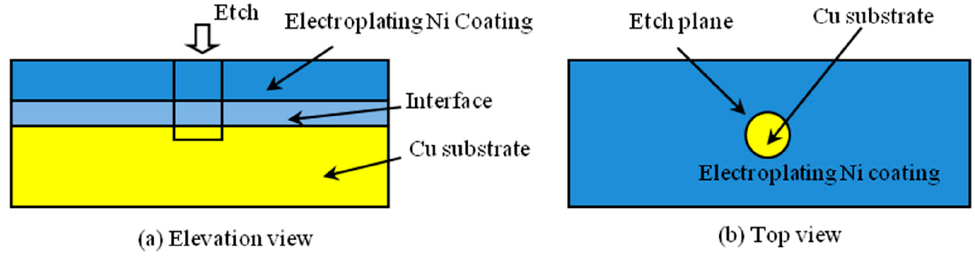
Figure 1. Schematic of the deep etching method: ( a ) elevation view; ( b ) top view. The XPS measurement was performed using an X-ray photoelectron spectrometer (Thermo Fisher Scientific K-Alpha, Shanghai, China) with a monochromatic Al K α X-ray source operated at 15 kV and 10 mA. All the binding energy values were corrected regarding C1s = 284.8 eV. According to the changing trend of the oxygen content along the vertical direction, the oxygen content of the substrate surface can be determined. The compressive stress was tested by the side incline diffraction method. As we all know, the XRD peaks at diffraction angles larger than 100 ◦ should be used to reach satisfactory precision when measuring the internal stress by the sin 2 ψ technique. In the experiments, the Ni(311) diffraction angle of the electroplating Ni coating is about 92.9 ◦ that may meet the requirement. However, the counts of the Ni(311) are too weak to reach satisfactory precision. Therefore, the Ni(111) was selected to measure the internal stress. In other studies, the Ni(111) angle was selected to measure the internal stress [19].Taking the sin 2 ψ as the horizontal coordinate and taking 2 θ under different ψ angles as the vertical coordinate, using the least square method to get the slope of the M , the internal stress can be calculated. The equations are as follows [19]: